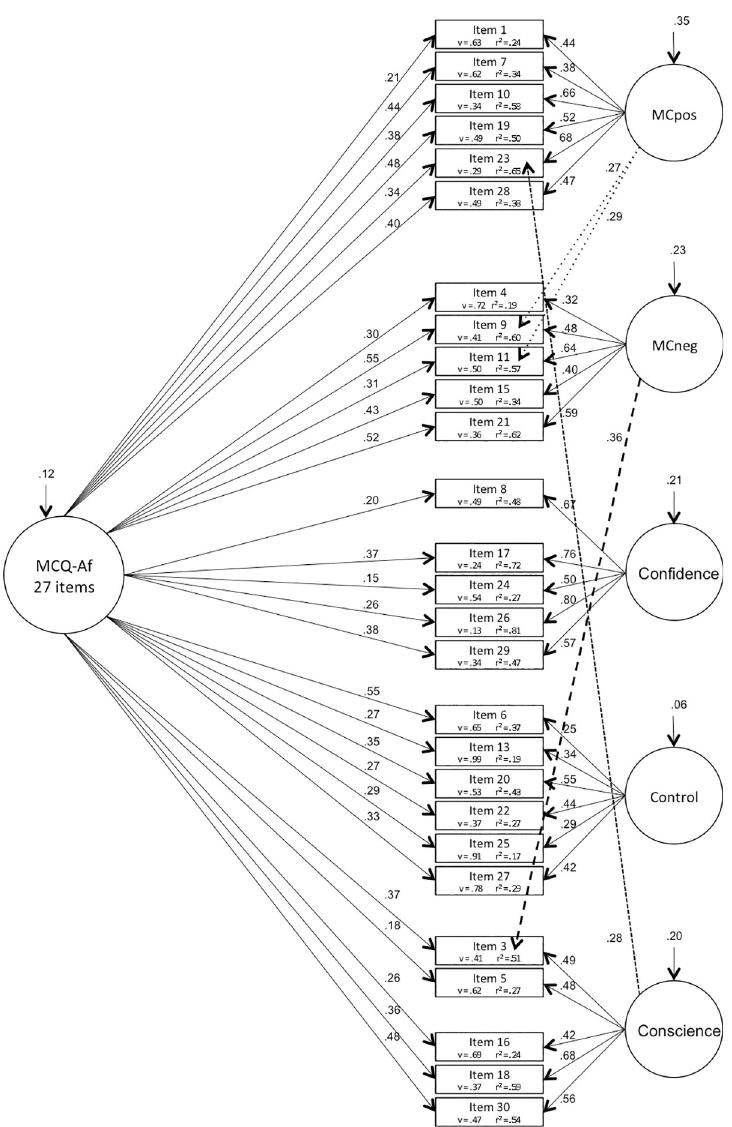
Fig 1. Bifactor model of MCQ-Af (27questions). Numbers arrowed on latent variables represent variance, v = variance; r 2 = squared multiple correlations.